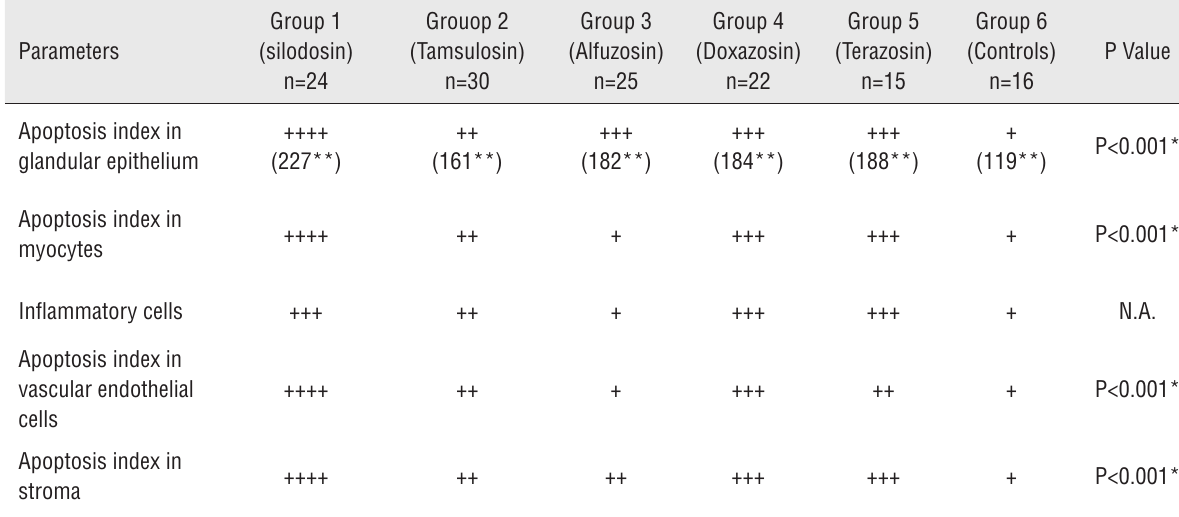
Table 3 - comparison of apoptosis indexes of